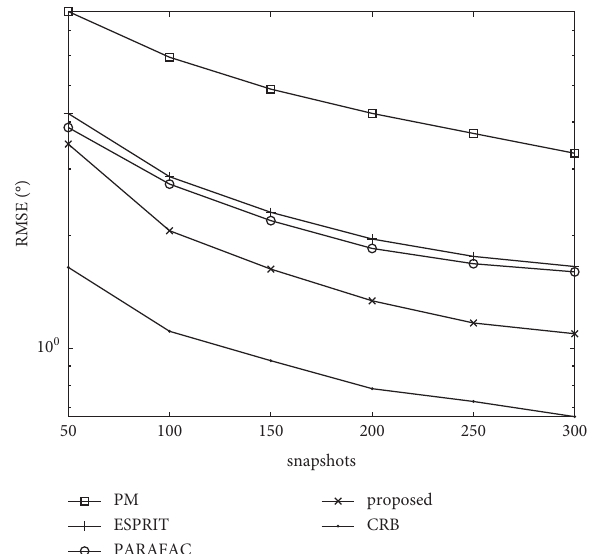
Figure 11: η estimation of different algorithms versus